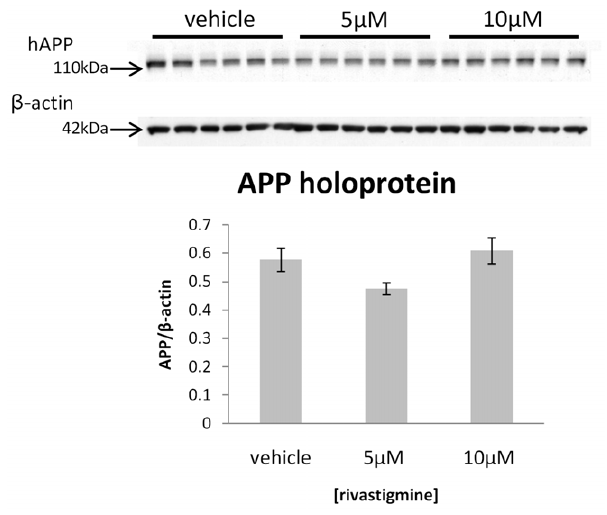
Figure 6. Rivastigmine does not alter APP holoprotein. APP levels in lysates of cerebrocortical cultures treated with vehicle or rivastigmine were measured by Western blot using the 22C11 antibody. No difference in APP holoprotein was found in either the 5 m M or 10 m M rivastigmine treatments, indicating that changes in sAPP levels are not the result of changes in total APP production in these